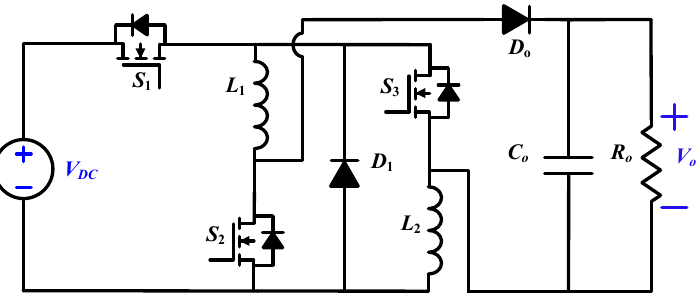
Figure 1. Proposed buck-boost dc–dc converter.